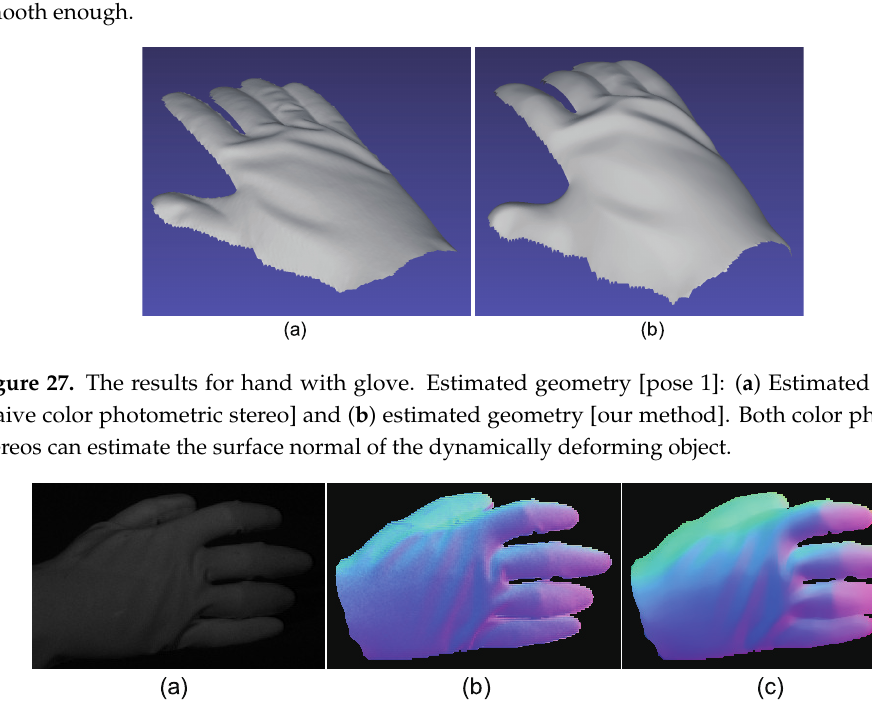
Figure 28. The results for hand with glove. Estimated surface normal [pose 2]: ( a ) One of the seven channel images, ( b ) estimated surface normal [naive color photometric stereo], and ( c ) estimated surface normal [our method]. Both color photometric stereos can estimate the surface normal of the dynamically deforming object.